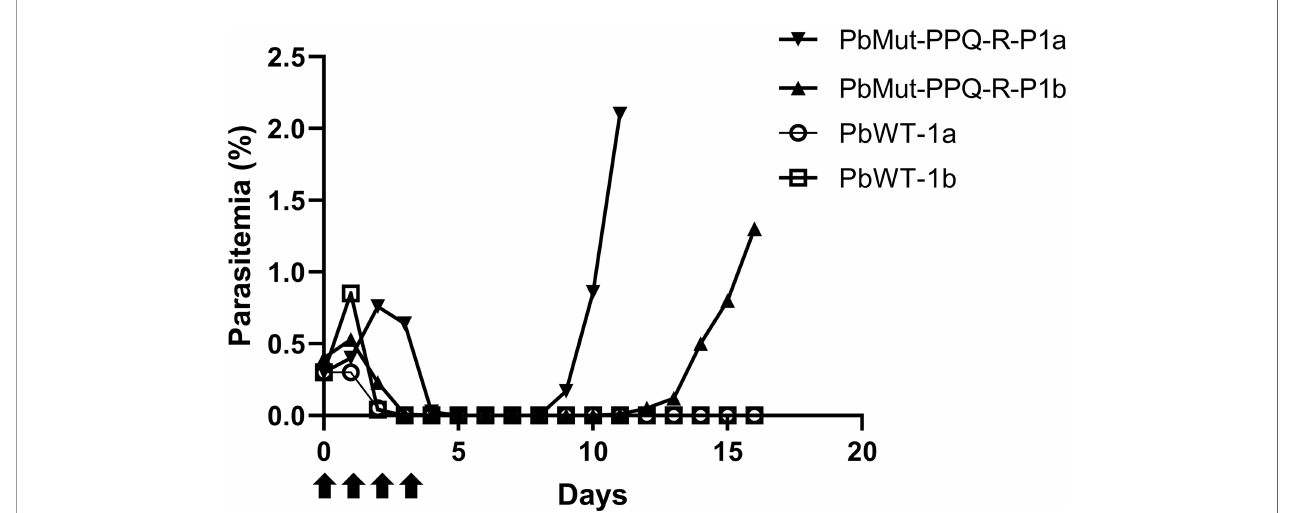
FIGURE 2 | Screening for PPQ-resistant parasites from PbMut. The fi rst screen for PPQ-resistant parasites. Two mice each were infected with PbMut (PbMut-PPQ- R-P1a; closed inverted triangle, and PbMut-PPQ-R-P1b; closed triangle) or PbWT (PbWT-P1a; open circle, and PbWT-P1b; open square). The mice were administered PPQ (15 mg/kg/day) for 4 days (arrows), and parasitemia was